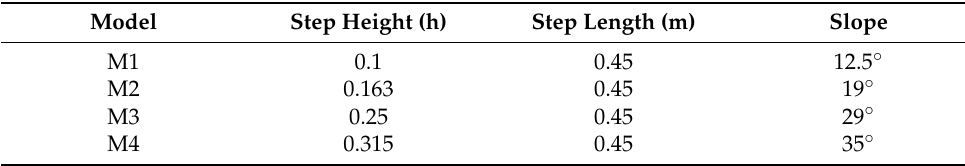
Figure 2. Three-dimensional stepped spillway models used for numerical experiments; ( a ) M 1 stepped spillway model with slope of 12.5 ◦ ; ( b ) M 2 stepped spillway model with slope of 20 ◦ ; ( c ) M 3 stepped spillway model with slope of 29 ◦ ; ( d ) M 4 stepped spillway model through a slope of 35 ◦ . Table 1. Details of the four models used for